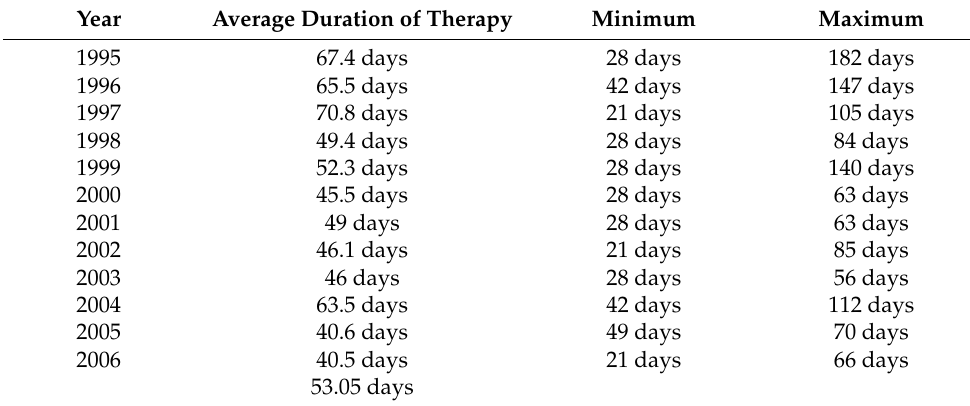
Table 3. Average duration of therapy in days to reach the defined